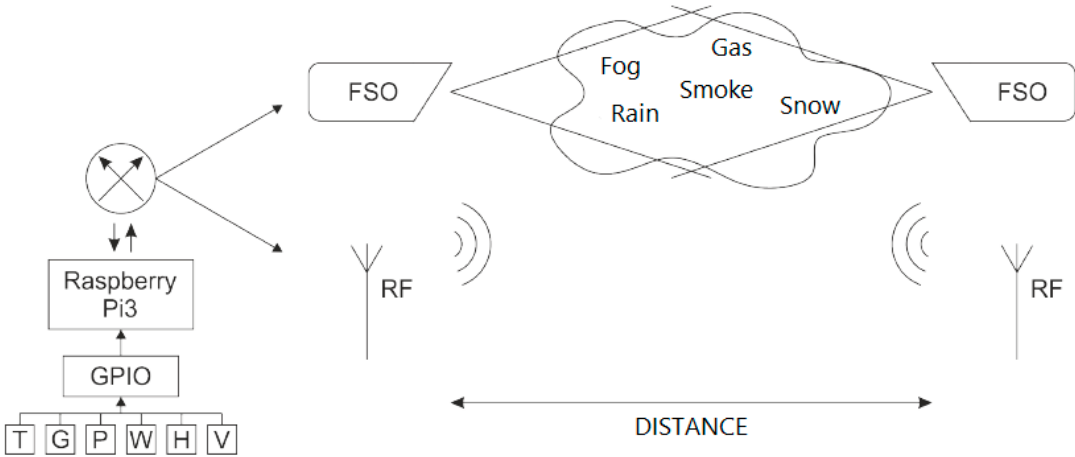
Figure 1. Scheme of the hybrid free space optics (FSO) / radio-frequency (RF) system.